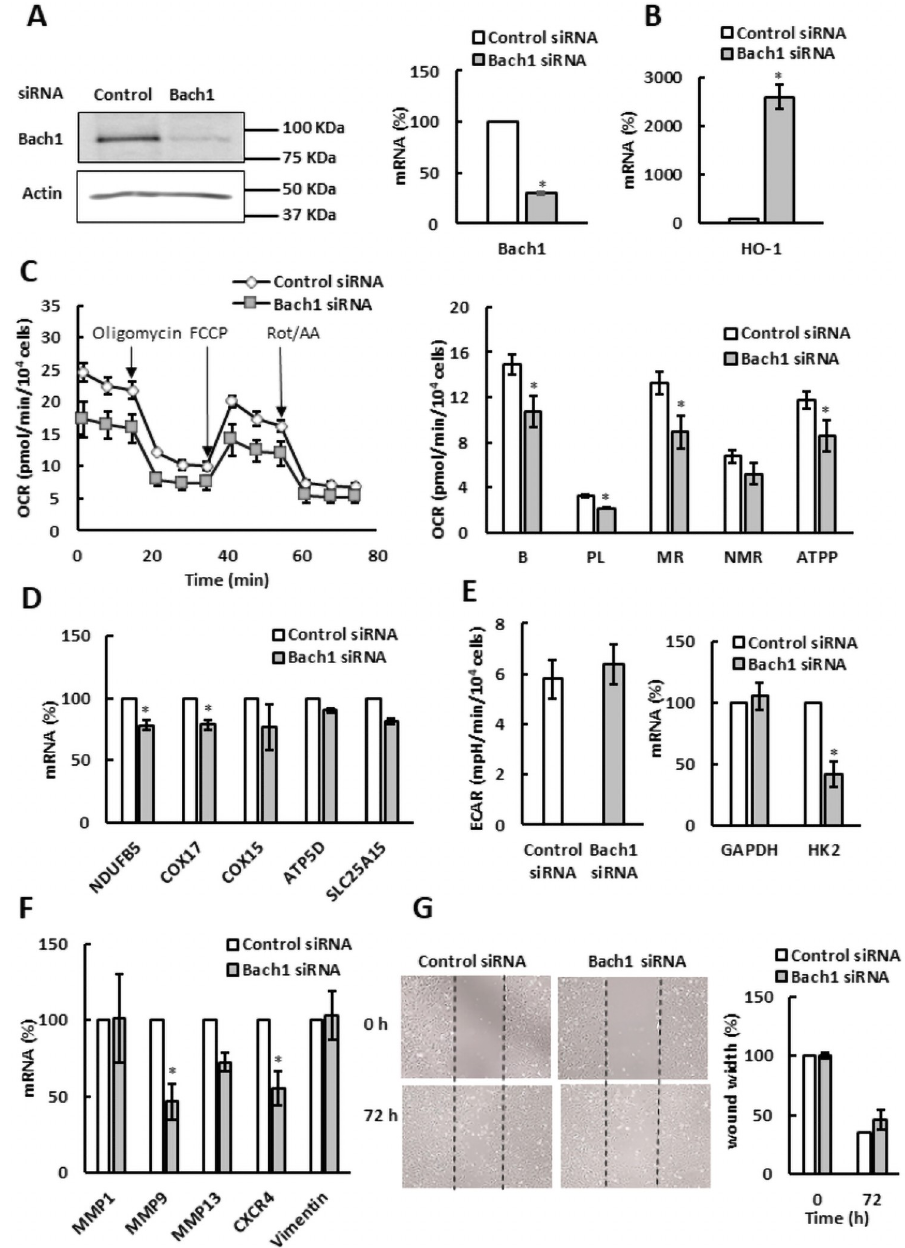
Fig 6. Bach1 regulates mitochondrial respiration in SKOV3 cells. SKOV3 cells were transfected with Bach1 or control siRNA and analyzed by (A) western blotting using Bach1 and actin antibodies and qRT-PCR. (B) HO-1 mRNA levels, (C) OCR, (D) expression of ETC and OXPHOS genes, (E) ECAR and GAPDH and HK2 mRNA levels, (F) expression of metastatic genes, and (G) migration of SKOV3 cells analyzed by wound healing assay (n = 3). (A-G) The experiments were repeated three times, and the numerical results are shown as means ± S.D. Values that are statistically different ( p < 0.05) from the control (SKOV3 cells transfected with control siRNA) are indicated by an